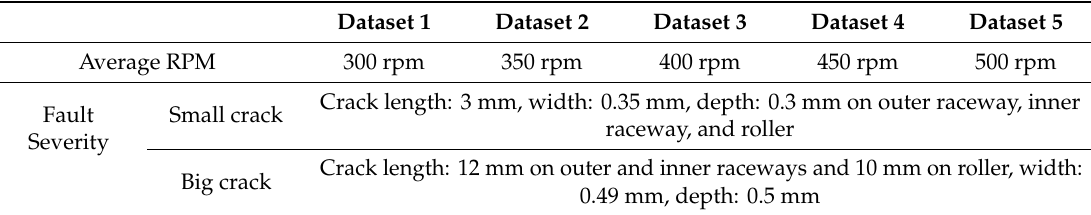
Table 1. Various datasets with the crack severity specifications considered in this